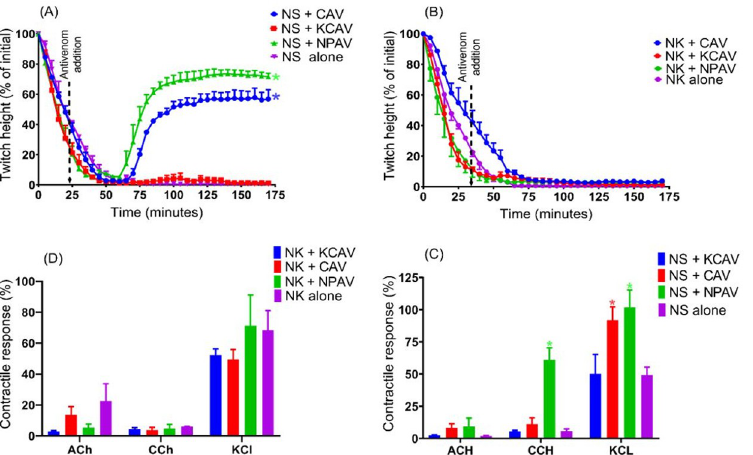
Fig 6. The effect of the addition of antivenom at the t 90 time point after exposure to Malaysian N . sumatrana venom and N . kaouthia v enom to the indirectly stimulated twitches and response to exogenous agonists. Panels (A) and (B) venom indicate change of indirect twitches when recommended titer of Cobra Antivenom (CAV), Neuro Polyvalent Antivenom (NPAV) and King Cobra Antivenom (KCAV) was added at t 90 point after addition of 5 μ g/ml N . sumatrana venom and N . kaouthia venom respectively. Panels (C) and (D) venom indicate contractile responses to exogenous agonists in tissues that were added with recommended titer of Cobra Antivenom (CAV), Neuro Polyvalent Antivenom (NPAV) or King Cobra Antivenom (KCAV) at the t 90 time point after addition of 5 μ g/ml N . sumatrana and N . kaouthia venoms, respectively. NS indicates N . sumatrana and NK indicates N . kaouthia � p < 0.05, significantly different from venom alone (n = 3, one-way